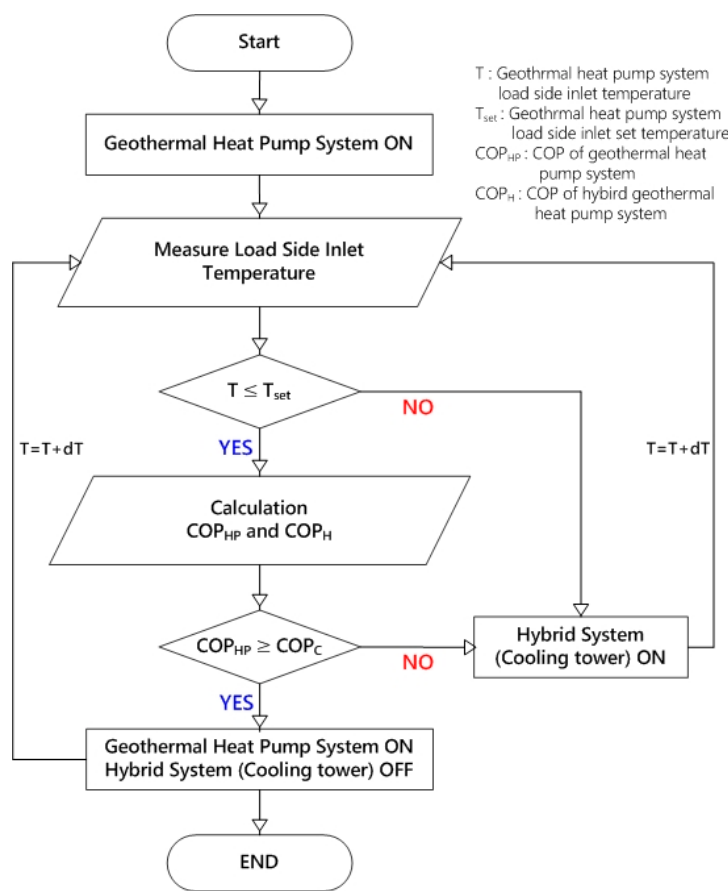
Figure 11. Algorithm of hybrid geothermal system operation.